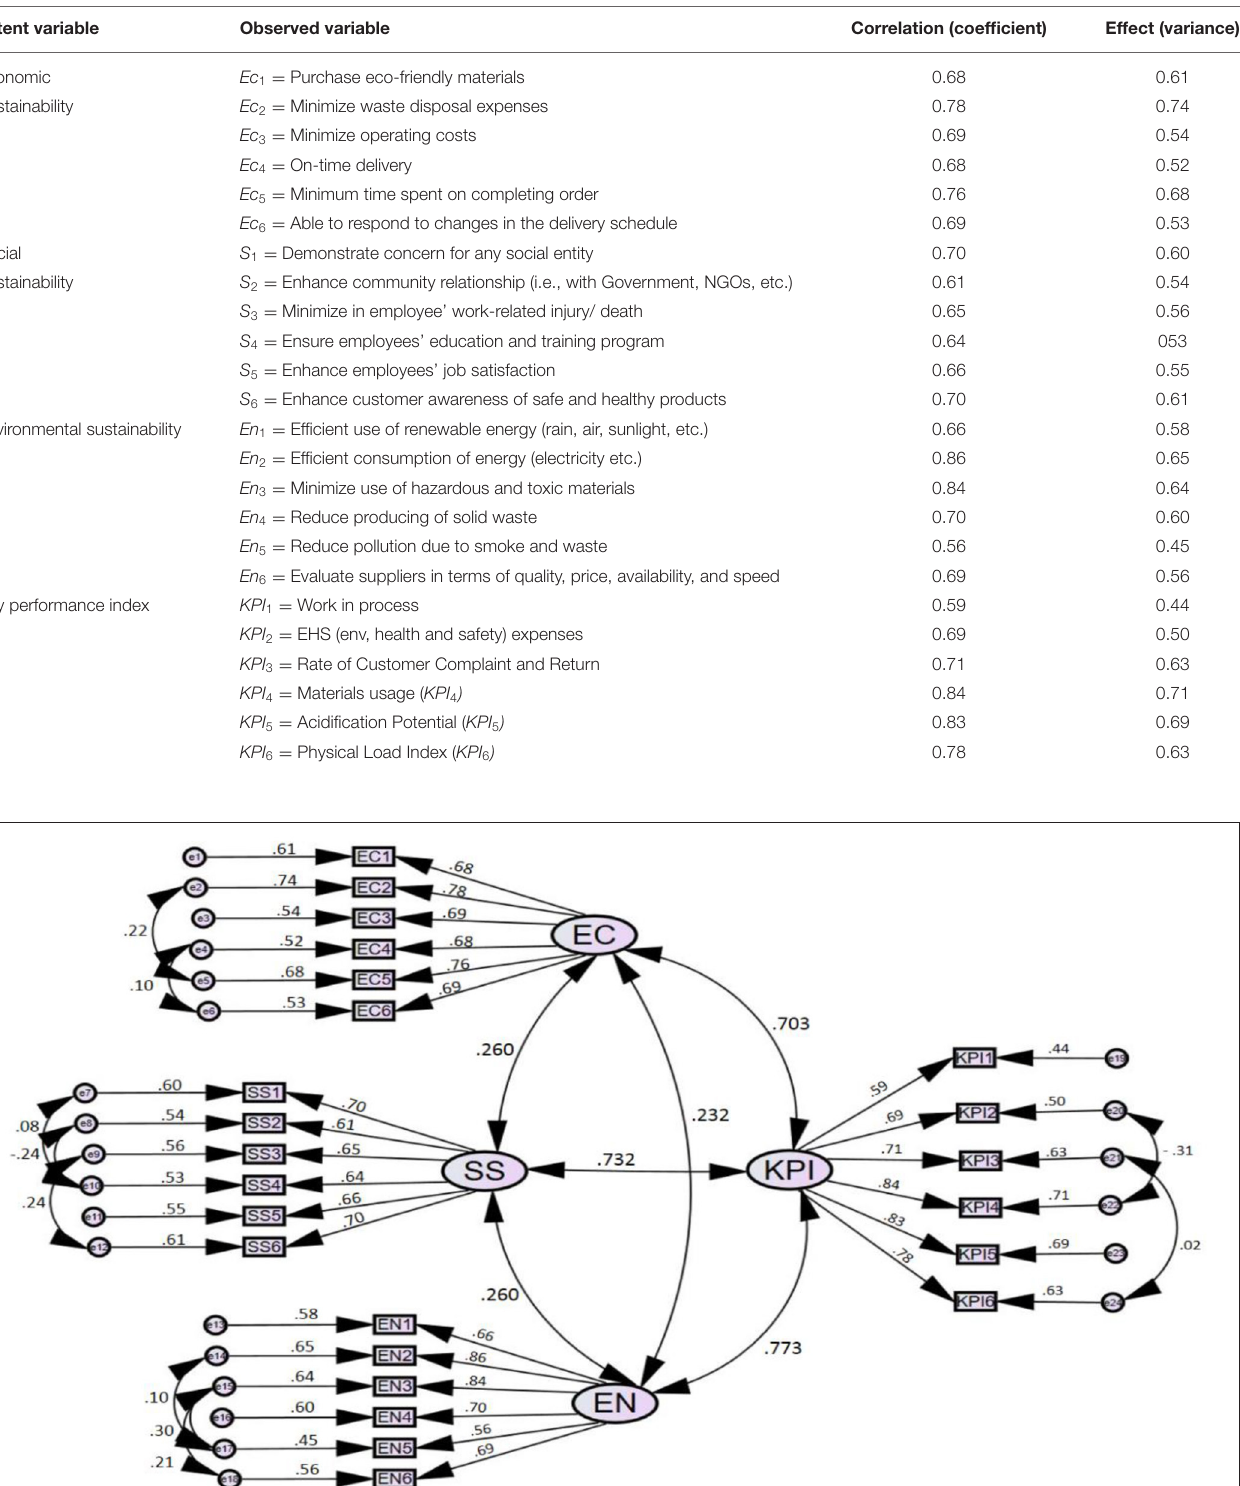
Frontiers in Sustainability |